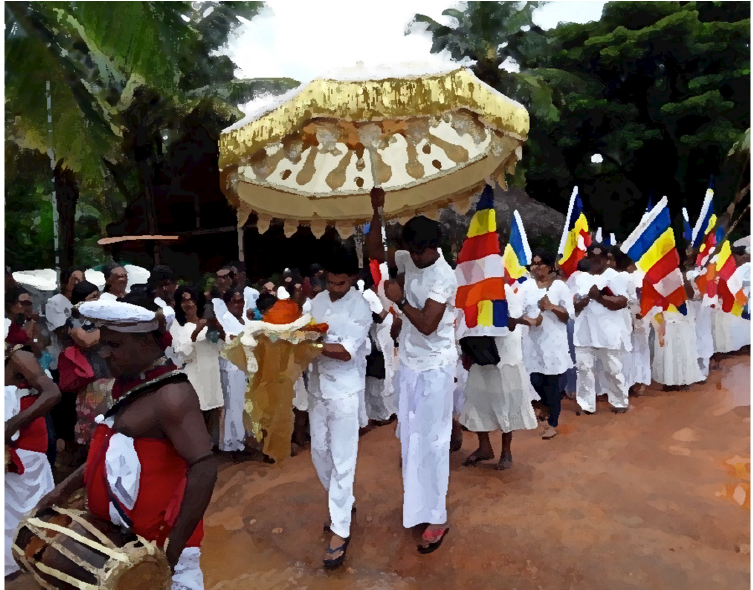
Figure 2. Katina robe is carried by the one of the primary donors in the procession under the pearl-encrusted umbrella. Photo by author. 19 October 2019, Umandawa Monastery, Kurunegala.